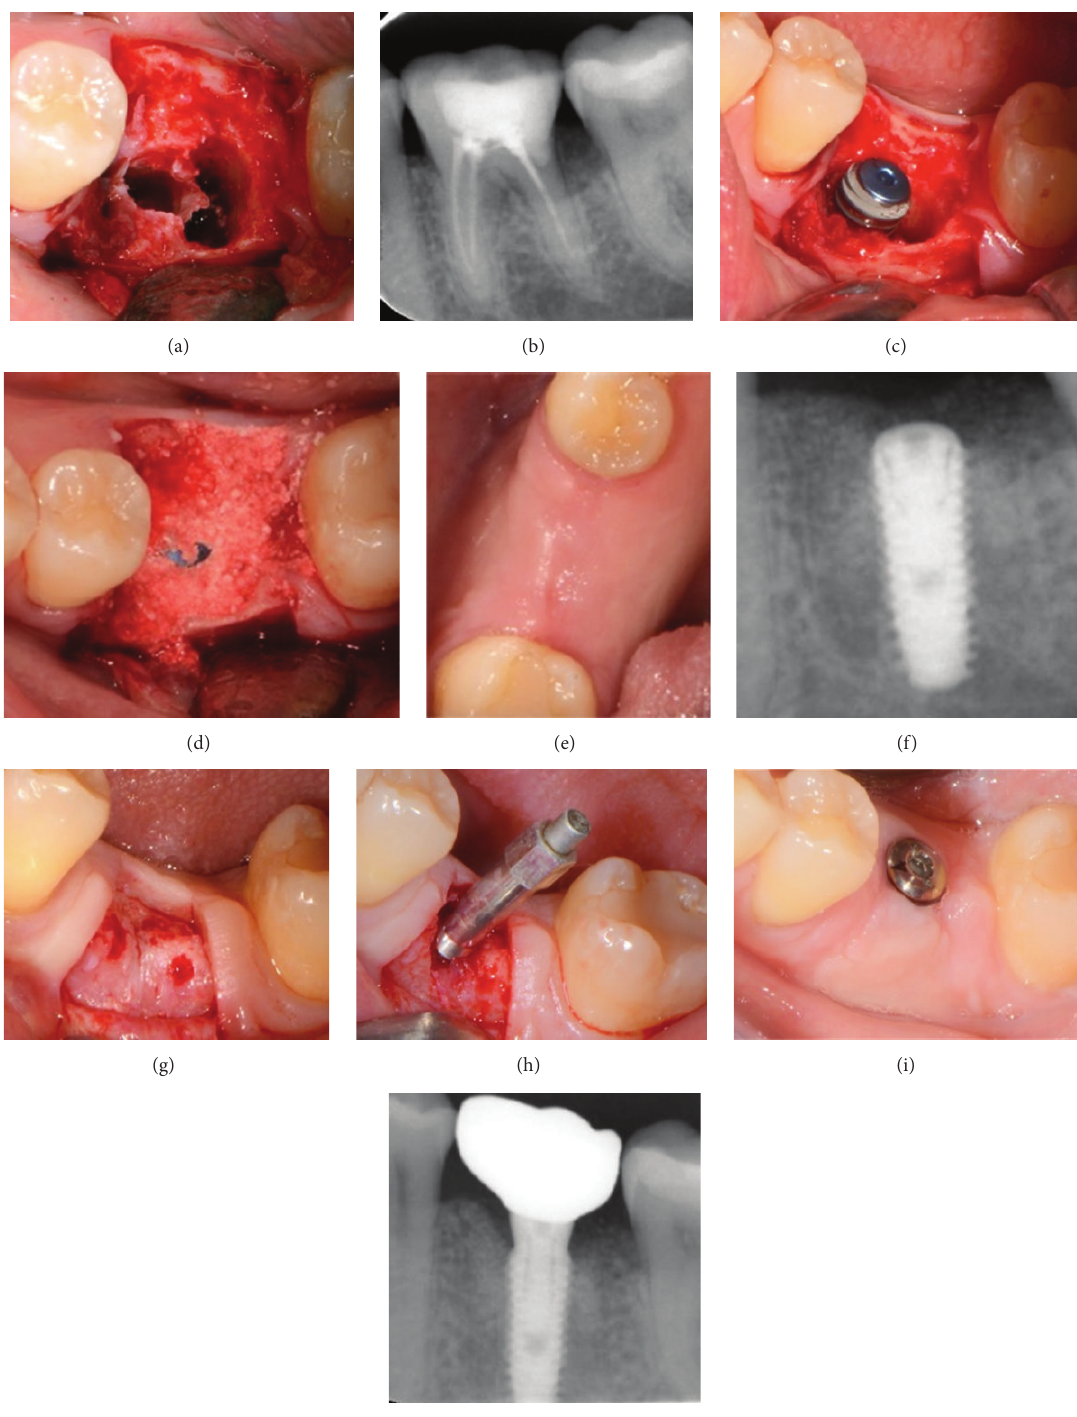
Figure 3: Case 1: a 47-year-old woman with crown and root fracture in the left mandibular first molar. (a) Clinical view of the site after thorough debridement of the socket. (b) Periapical X-ray of the nonrestorable tooth. (c) Implant placement at the correct 3D positioning. ISQ reading was 48. (d) Grafting with 𝛽 -TCP/CS (Ethoss). (e) Clinical view after 10 weeks. (f) X-ray 10 weeks after implant placement and graftingshowingtheconsolidationofthegraftingmaterialaroundtheimplantandnewboneformationovertheimplantheadandtowardsthe adjacent interproximal heights of bone. (g) At reentry the site is filled with regenerated bone. Note the head of the implant covered by newly formed bone. (h) After removing the supernatant newly formed bone with a round burr implant stability is assessed (ISQ measurement: 78) revealing a significant increase through the 10-week healing period. (i) Maturation of the soft tissues 2 weeks after placement of the healing abutment. (j) X-ray 9 months after